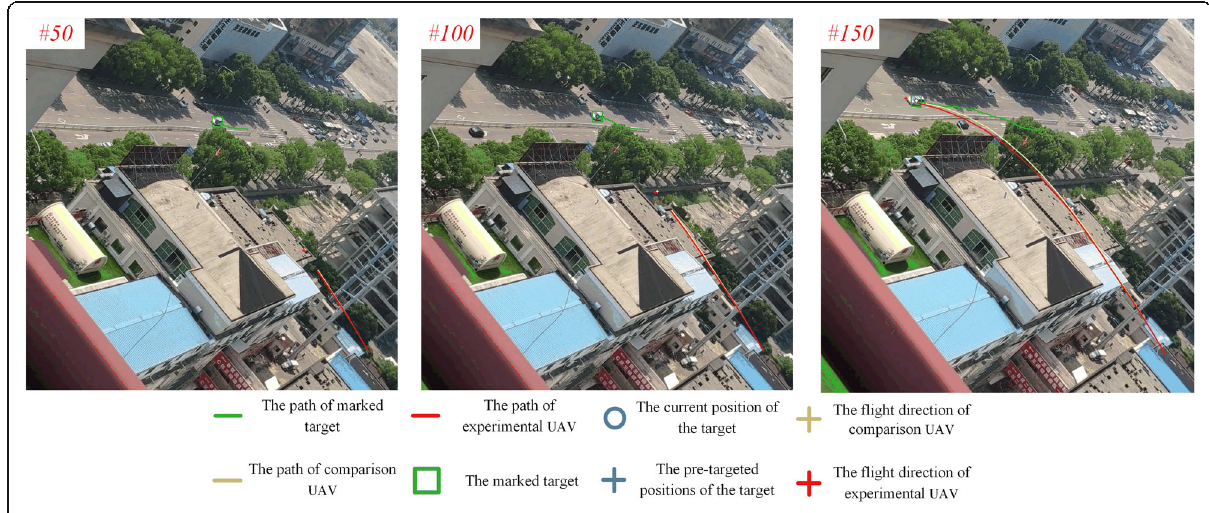
Fig. 7 The experimental results of the simulation of a single moving target